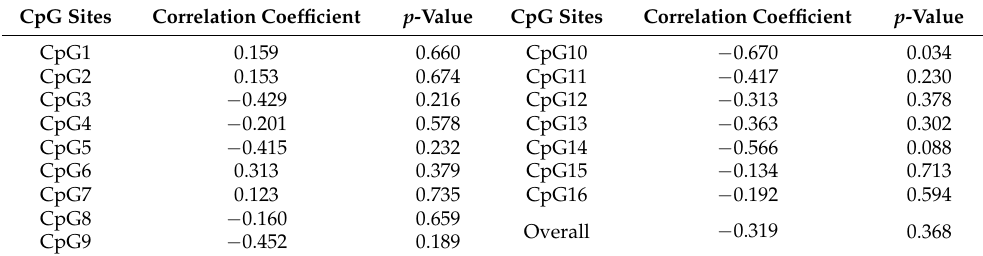
Table 6. Correlation coefficient of CpG I methylation rate and KRT17